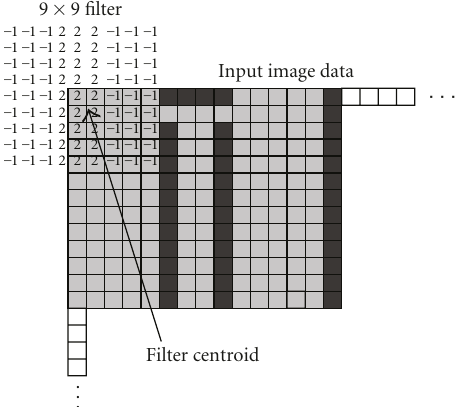
Figure 3: 9 × 9 filter computing the filtering of the top left portion of hypothetical input energy data. In this instance, each coe ffi cient of the filter is multiplied by the corresponding image data within the scope of the filter (filter kernel) where some of the data is repeated from the opposite side. These filter coe ffi cient and input data products make up a partial result, the sums of which generate a local result corresponding to the centroid of the